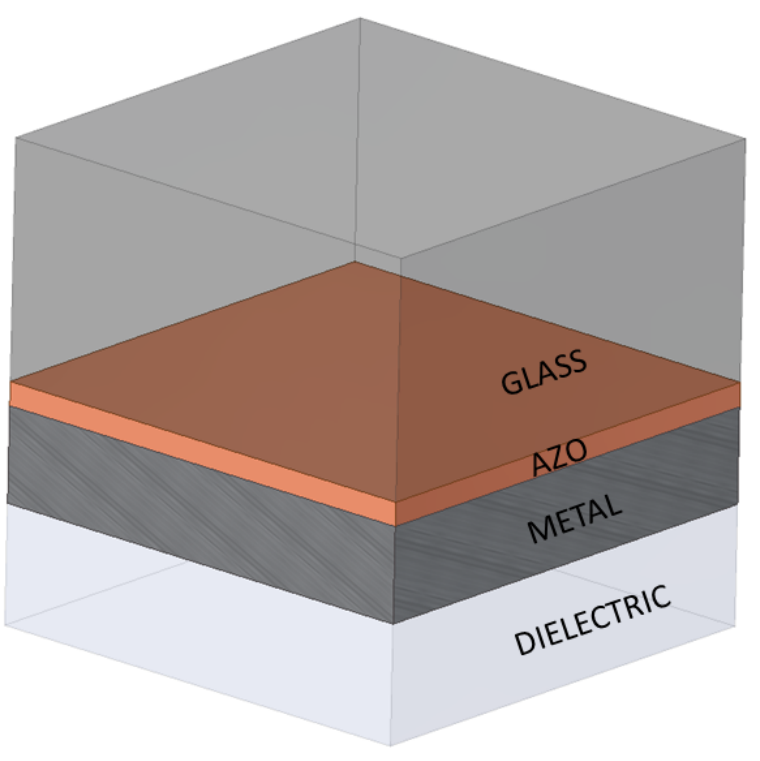
Figure 1. Structure of the thin-film solar device. The AZO (conductive aluminium-doped zinc oxide) layer is placed between the glass and the metal